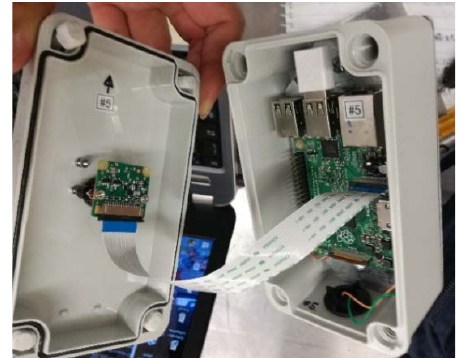
Figure 1. The RPi2B connected with the PiCamera